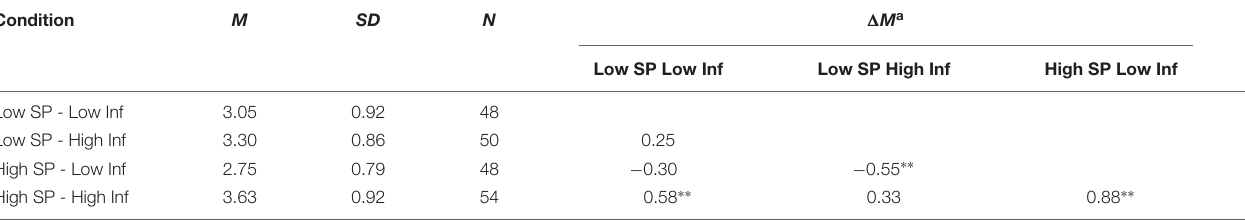
TABLE 3 | Organizational Attractiveness per Condition: Means, Standard Deviations, Sample Sizes, and Mean Differences.